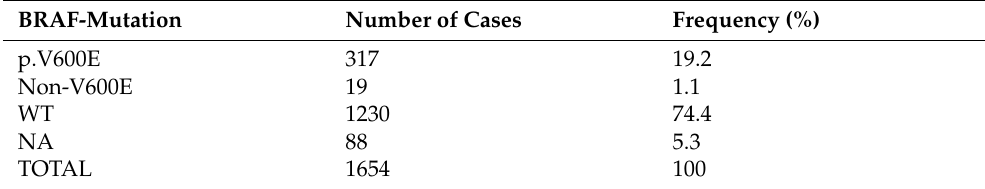
Table 1. BRAF results in the cohort